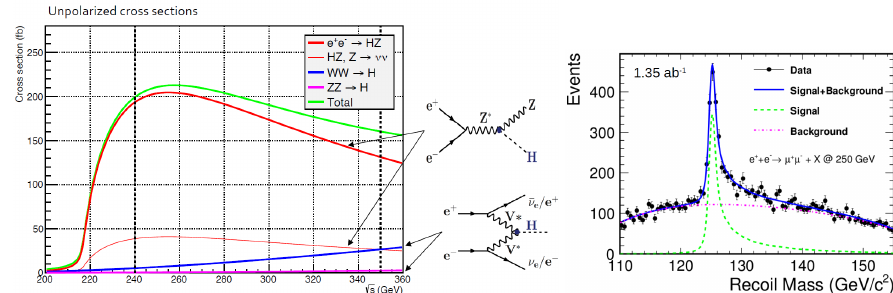
Figure 5. The Higgs boson [production cross-section as a function of CM energy (left plot, from [21]). Distribution of the mass recoiling against the muon pair in the process e + e − → HZ ( → µ + µ − ) (right plot, from